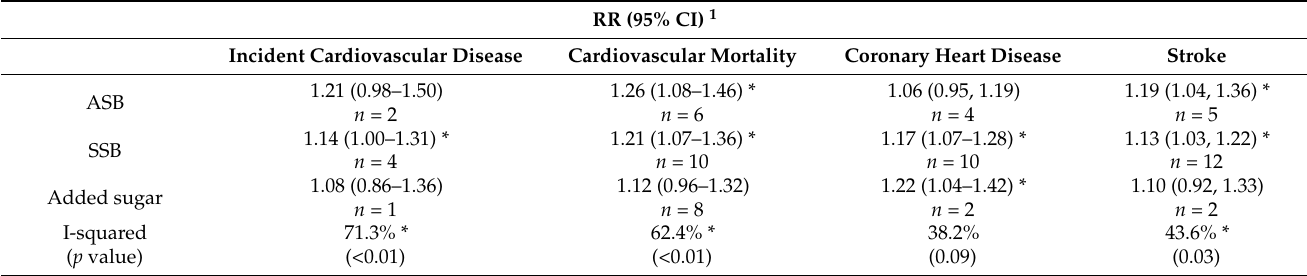
Table 5. Associations between added sugar, SSBs, ASBs, and the risk of cardiovascular outcomes in the random-effects network